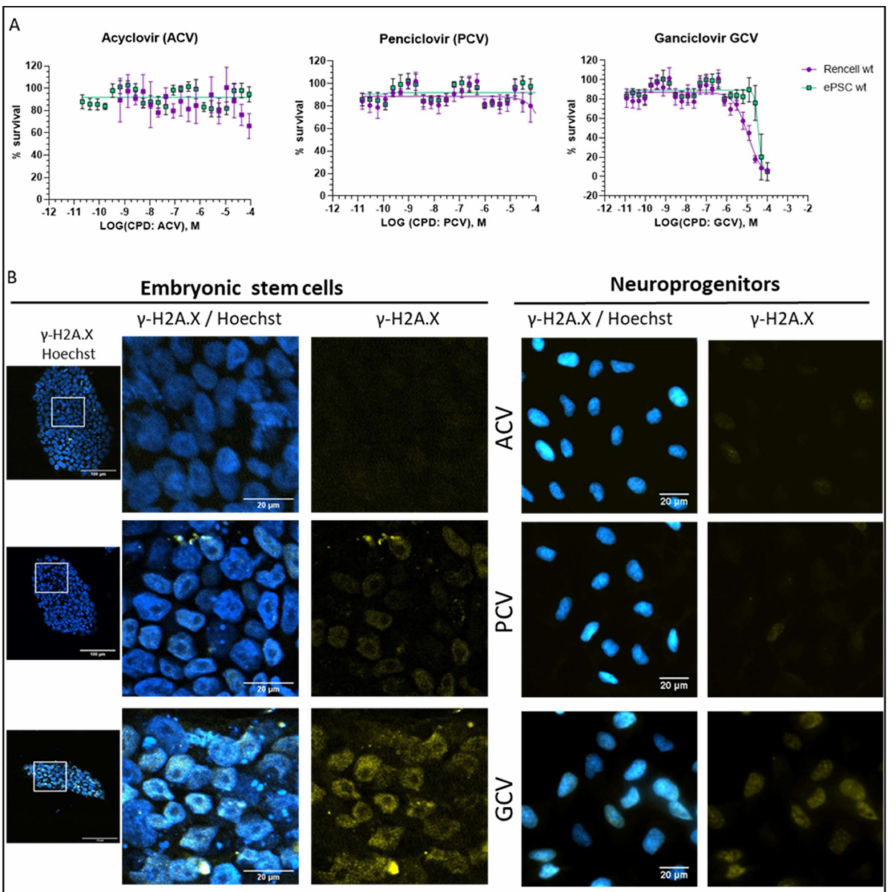
Figure 6. Impact of antiviral nucleoside analogs on non-transduced hESC and neuroprogenitor cells ( A ) Toxicity of ACV, PCV, and GCV in non-transduced hESC and neuroprogenitors (proliferating ReNcells), detected by an ATP-based assay (nucleoside exposure time 96 h, n = 3). ( B ) DNA damage induced by guanosine analogs ACV, PCV and GCV in non-transduced cells. Cells were exposed to 100 µ M of the respective nucleoside for 48 h. DNA damage was monitored using γ -H2A.X marker [24] in yellow and nuclei were counterstained with Hoechst. The white box in the first column indicates the area of the zoom for the hESC